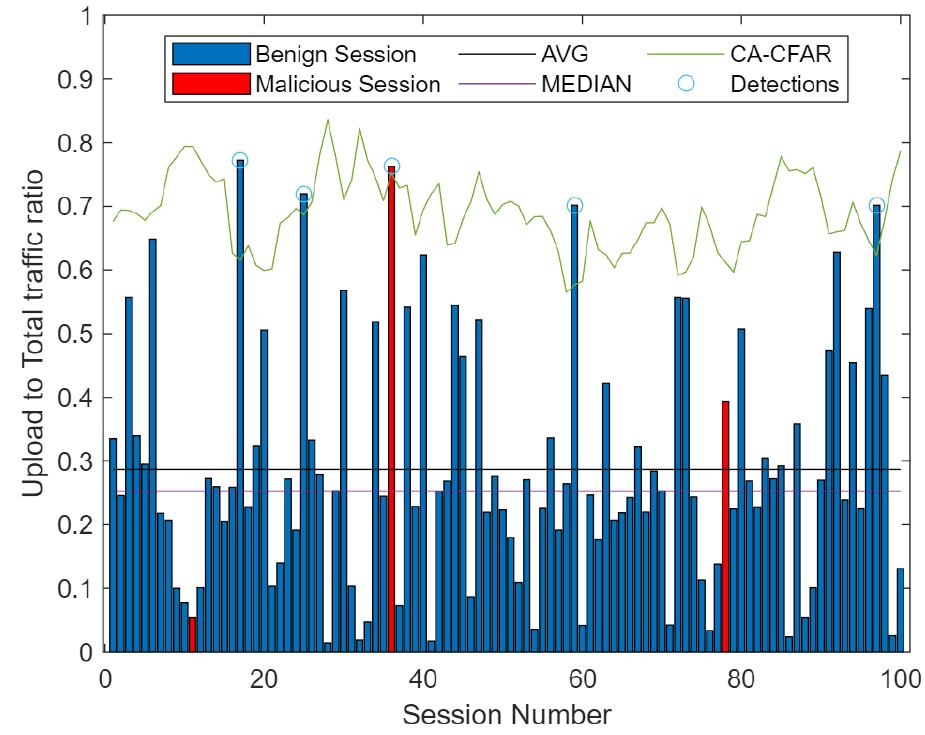
Figure 22. Detection based on the information about upload